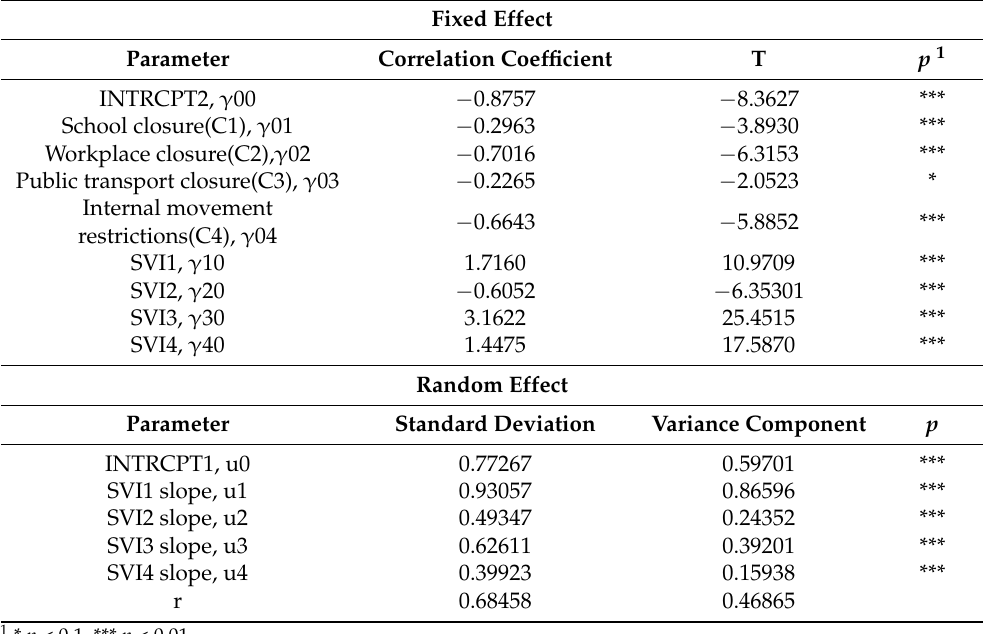
Table 3. Complete HLM results for the infection